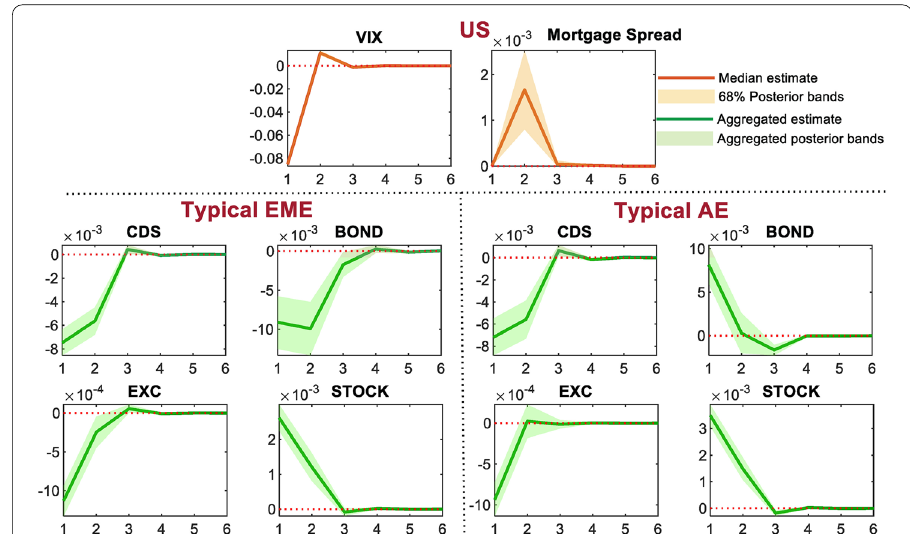
Fig. 7 Effects of a negative VIX shock on typical EME and AE financial variables. Notes : The upper panel shows the country-level (US) impulse responses to a negative VIX shock along with the 68% posterior probability bands. The lower panels indicate the average responses (Typical EME and AE) to the VIX shock. The average impulse response functions are calculated as a simple arithmetic average of the country-specific impulse response functions of 20 EMEs and 20 AEs. The country-level impulse responses to a negative VIX shock are available from the authors upon